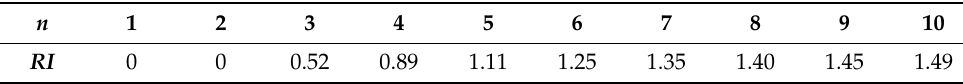
Table 3. Random Index table values